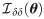
The key characteristics of metabolic RNA labeling experiments.A: The diagonal term of the Fisher information matrix (FIM) Iδδ(θ), as a function of the ratio of labeling time t to the characteristic time of degradation τ = 1/δ for the case of SLAMseq experiment. Read counts follow the Poisson distribution, the expression level is μ = 1 and the degradation rate is δ = 1. B: 95% confidence interval (CI) relative width of the degradation rates for different sets of time points included in the simulation of the SLAMseq experiment. We simulated counts for a range of rates δ and assumed for simplicity that normalization factors are perfectly known but not the rates and expression levels. Smoothed data from 10 simulation runs is shown. C: Relative standard deviation (sd(δ^)/δ) of the MLE for δ as a function of measurement time at different values of the overdispersion parameter k. With increasing overdispersion, the profile of the dependency flattens. However, near the optimal time point, variance of the estimation is more sensitive to time of labeling, which complicates the optimal design choice for different δ ranges. Expression level is fixed to μ = 100 reads in this example, the degradation rate is assumed to be δ = 1. The FIM I(θ)=nI1(θ) is calculated for n = 1. D: Relative standard deviation (sd(δ^)/δ) for a model with overdispersion (k = 100, solid line) or with no overdispersion (k → ∞, dashed line). The degradation rate is δ = 1, the labeling time is t = 1. The FIM I(θ)=nI1(θ) is calculated for n = 1.